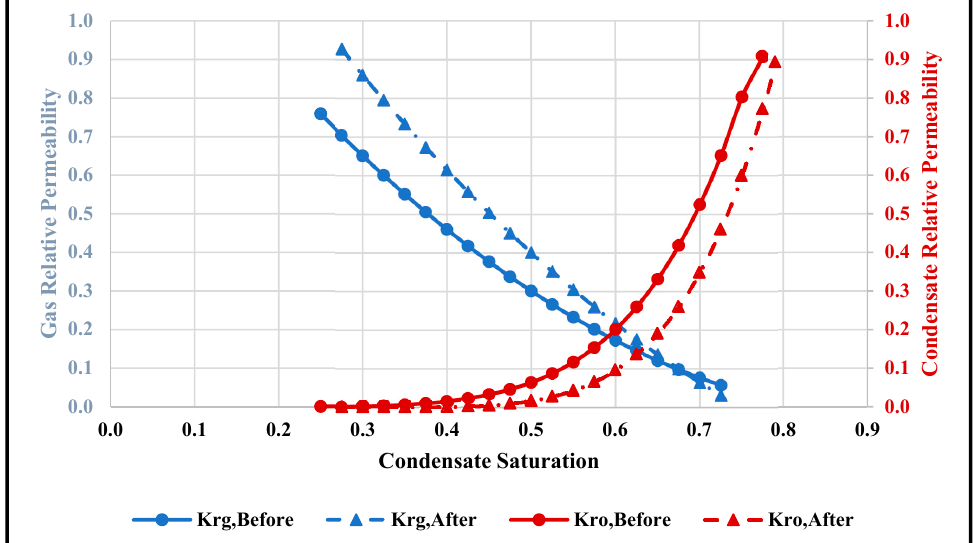
Figure 9. Relative permeability curves for gas (K rg ) and condensate (K ro ).